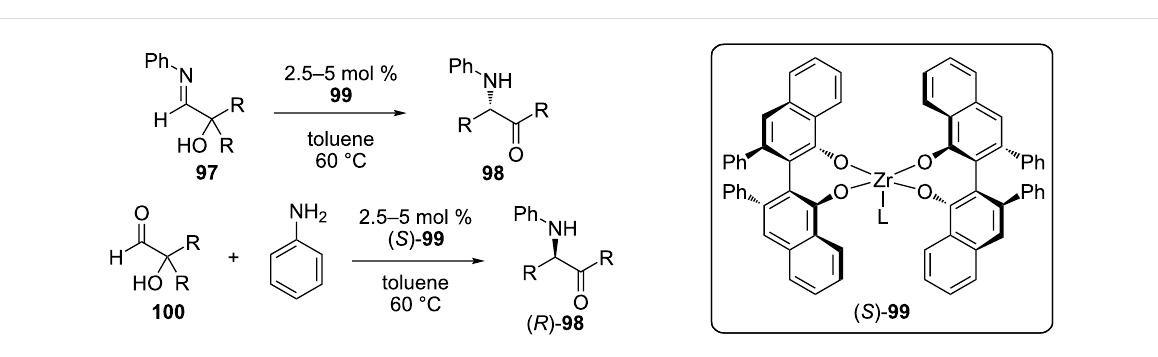
montmorillonite K 10 had the best yields (95% and 100%, re- spectively). A substrate scope was then determined for 97 using aryl, n -hexyl, and cyclohexyl R groups in the presence of silica gel at 80 °C (Figure 19b). The rearrangements proceeded well with electron-rich aryl groups, regardless of the position of sub- stitution, but the reaction was especially slow for the electron- withdrawing para -trifluoromethyl